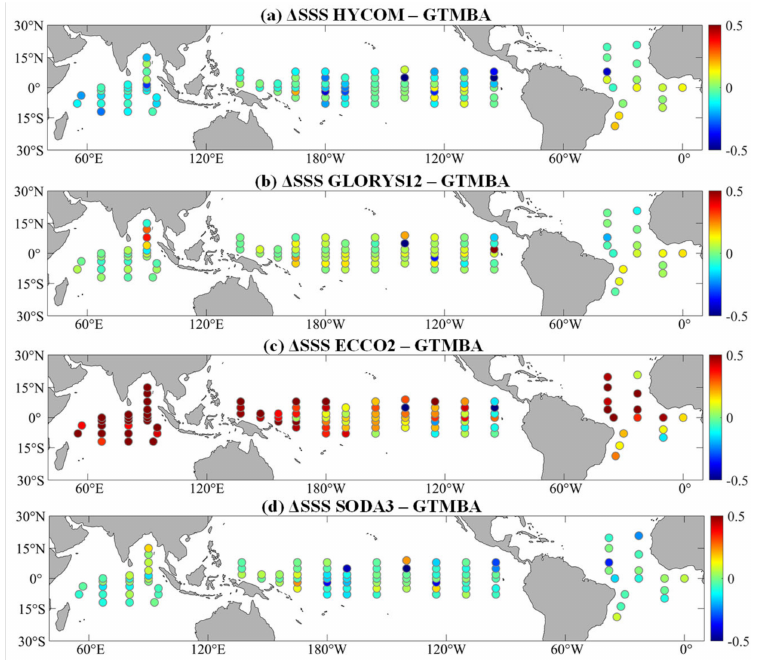
Figure 11. Same as Figure 10 but in terms of ∆ SSS